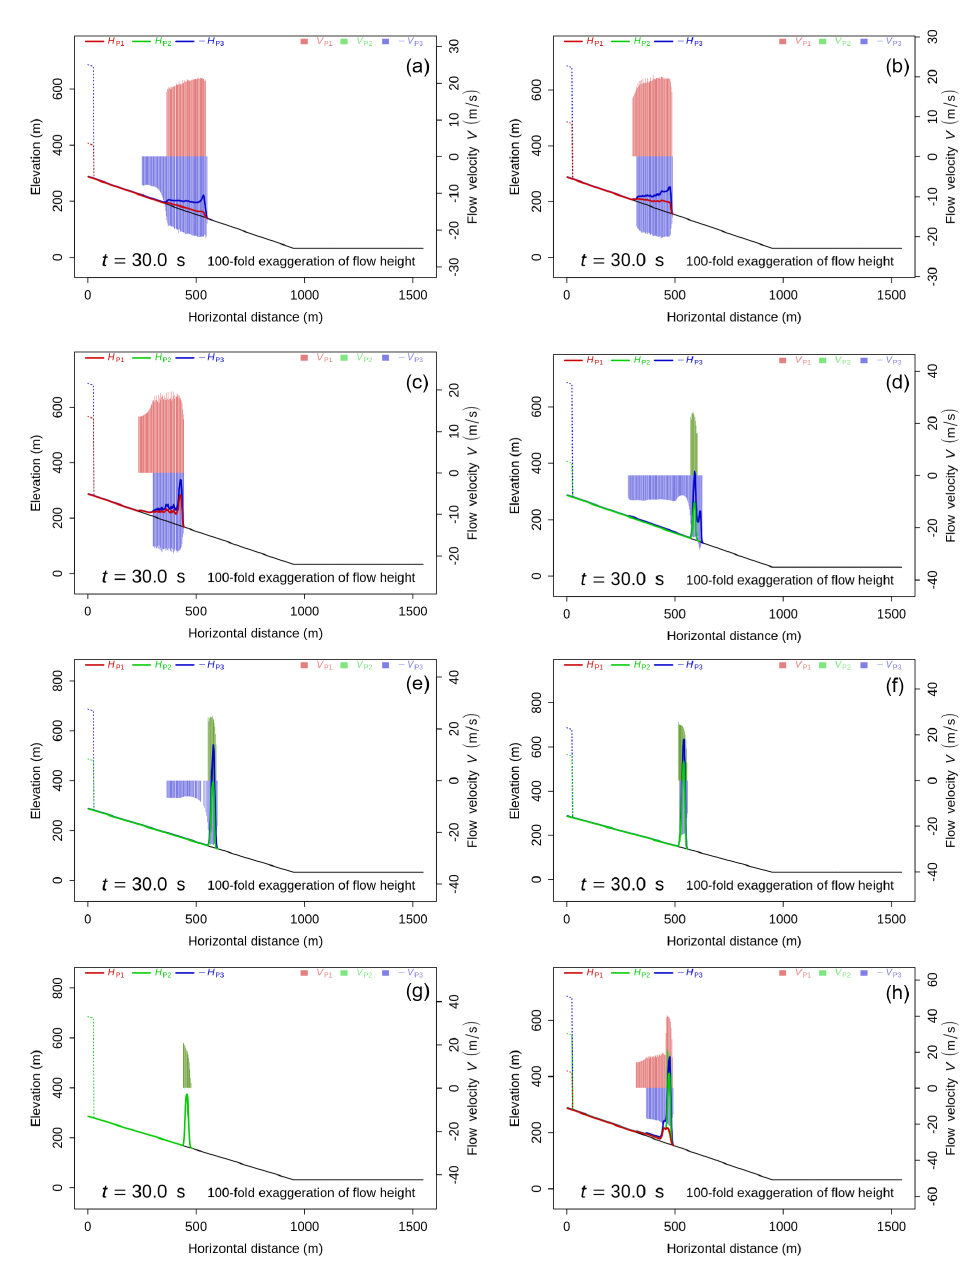
Figure 4. Velocity and height of individual phases at 30 s after flow initiation for ( a ) D3; ( b ) D5; ( c ) D7; ( d ) M3; ( e ) M5; ( f ) M7; ( g ) E1; ( h ) C1. The solid line represents the flow height and the bar chart the flow